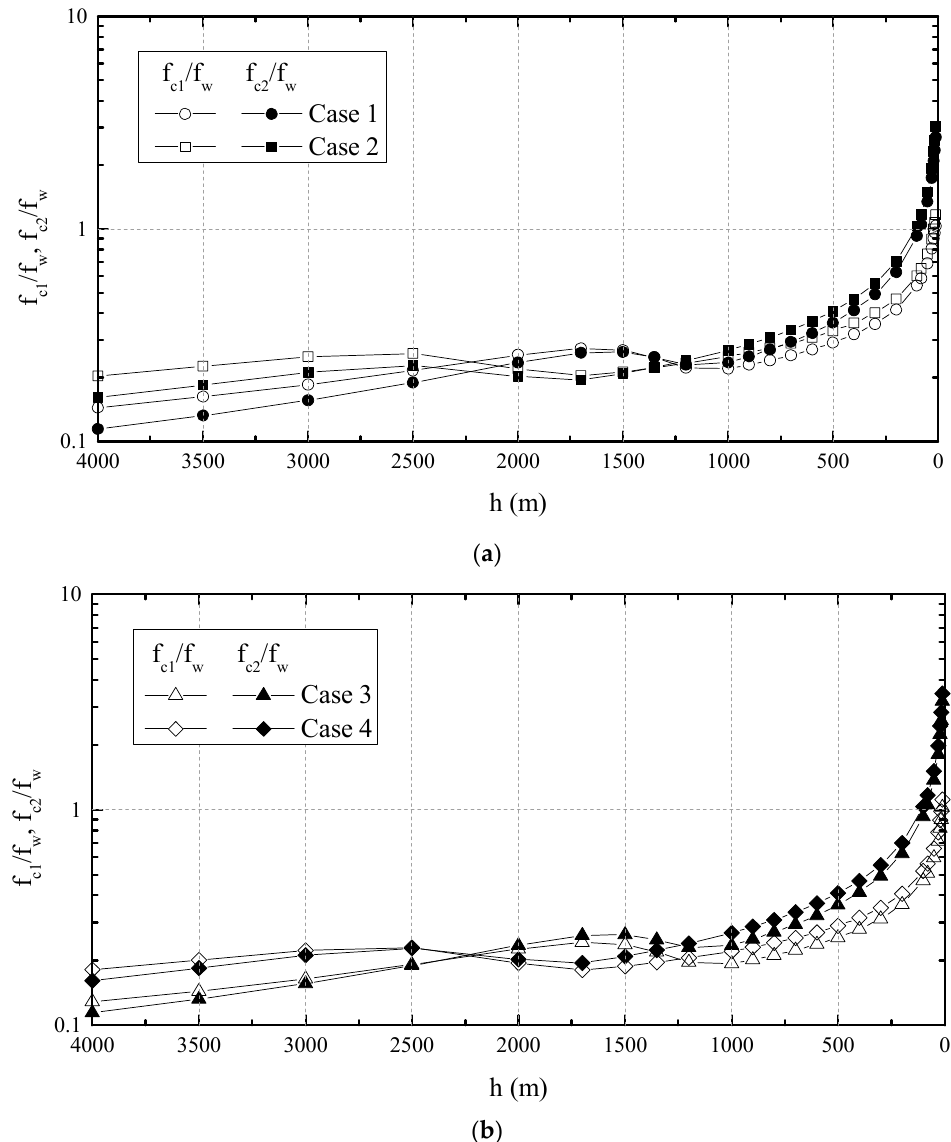
Figure 8. Comparison among Equations (11), (32) and (33). ( a ) Case 1, Case 2 ( d = 0.3 mm). ( b ) Case 3, Case 4 ( d = 0.1 mm).